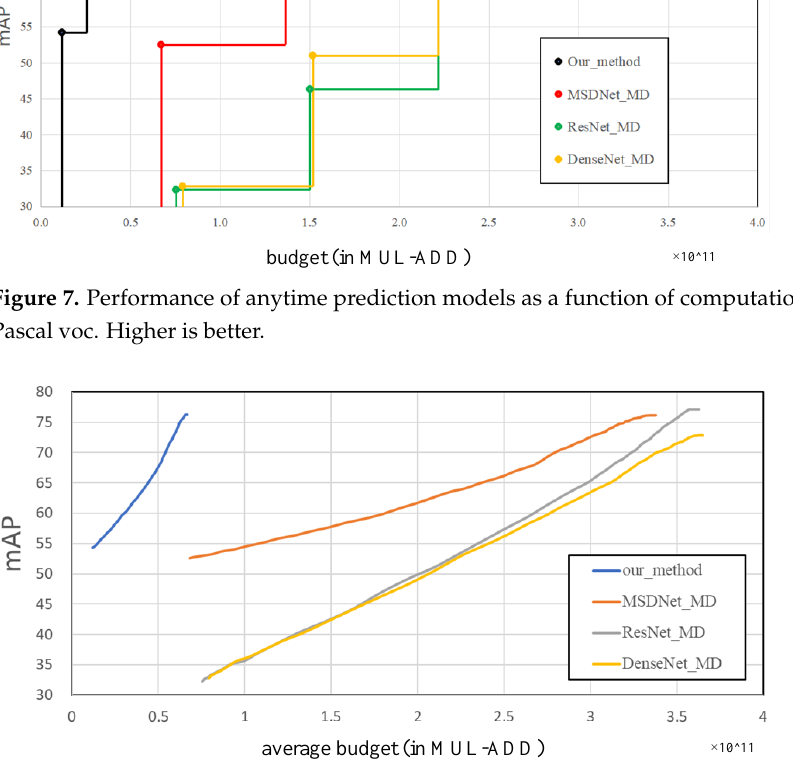
Figure 8. Performance of budgeted batch object detection models as a function of average computa- tional budget per image the on Pascal voc. Higher is better.